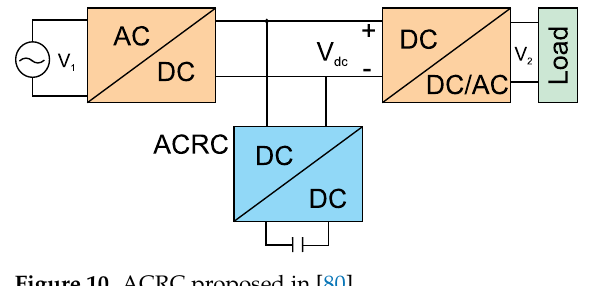
Figure 10. ACRC proposed in